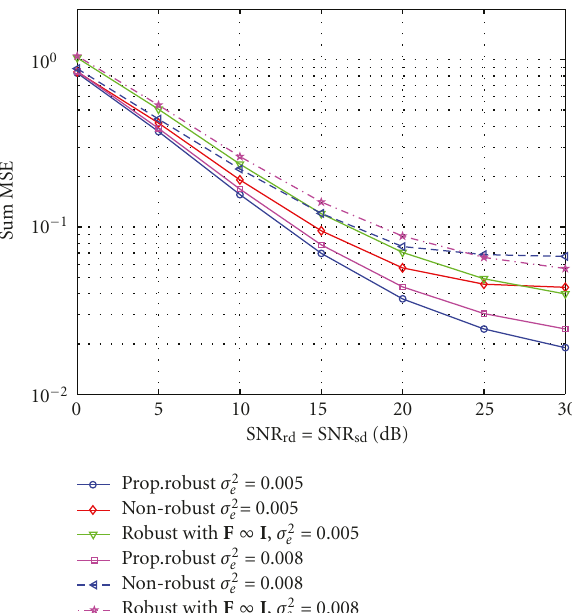
Figure 4: Sum MSE as a function of SNR (SNR r d = SNR s d ) for the relay channel with the direct link ( α = 0 . 6, β = 0 . 4, σ 2 = P max = , and P max σ 2 e ,0 = σ 2 S R e